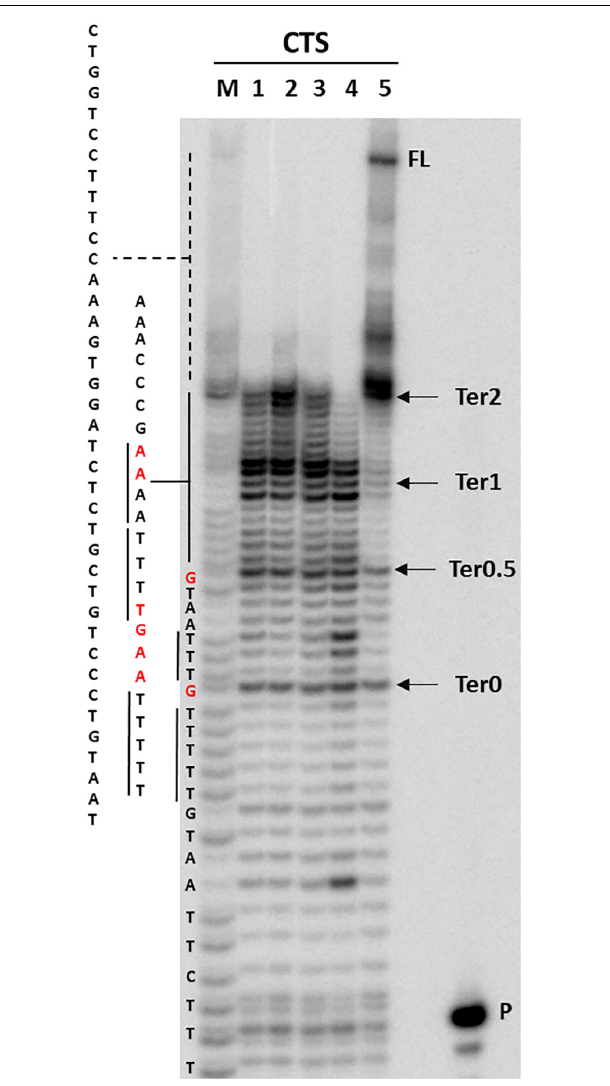
FIGURE 6 | Taq polymerase stop assay on HIV-1 CTS sequence. Analysis was performed in the absence (lane 5) or presence of 100 mM different salt types, such a KCl (1), NaCl (2), LiCl (3), and NaF (4). P indicates the unreacted labeled primer; FL indicates the full-length elongation product. Arrows indicate the previously reported termination sites (Lavigne et al., 1997). Bases relative to stop sites are reported in